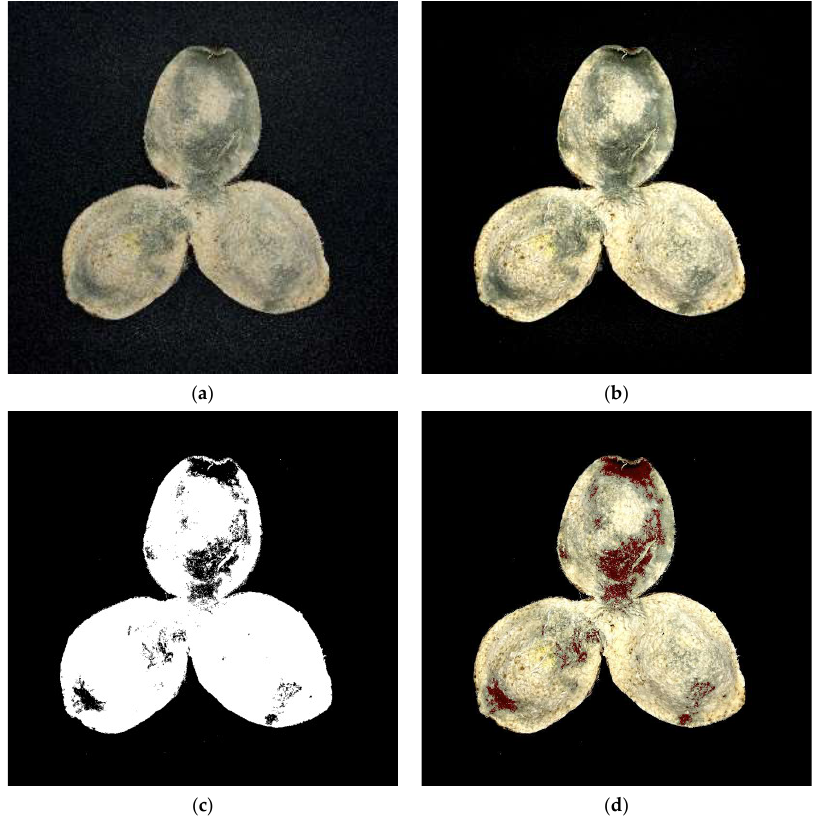
Figure 11. Image characterization of a moldy PCRC sample. ( a ) Original image of moldy PCRC; ( b ) Image after denoising and contrast optimization; ( c ) Image segmented by EXR and Otus methods; ( d ) The stacking image